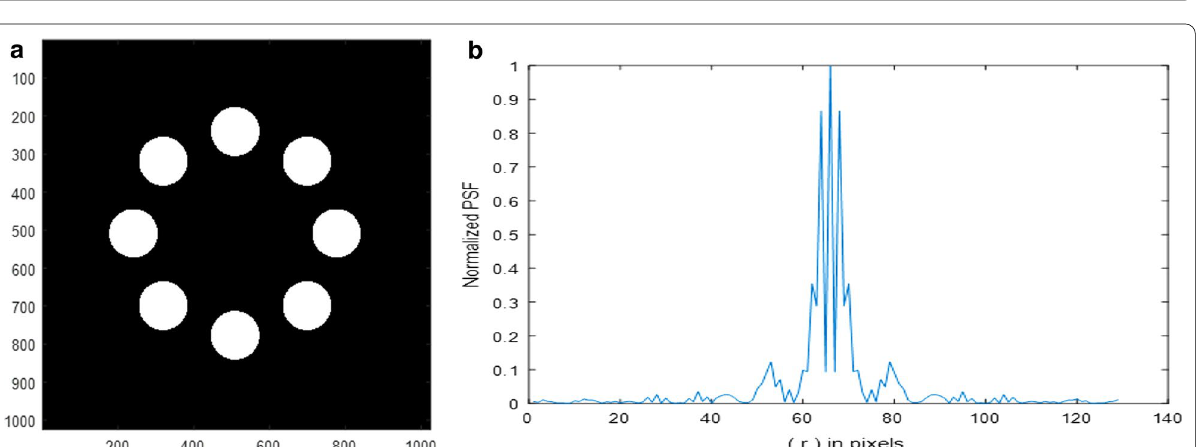
Fig. 3 a Eight equally spaced quadratic apertures where the centers placed at fixed distance radius of each conic aperture 64 pixels. b Normalized PSF as a function of radial distance r (pixels) in the Fourier plane for a lens limited by the = aperture shown in Figure a